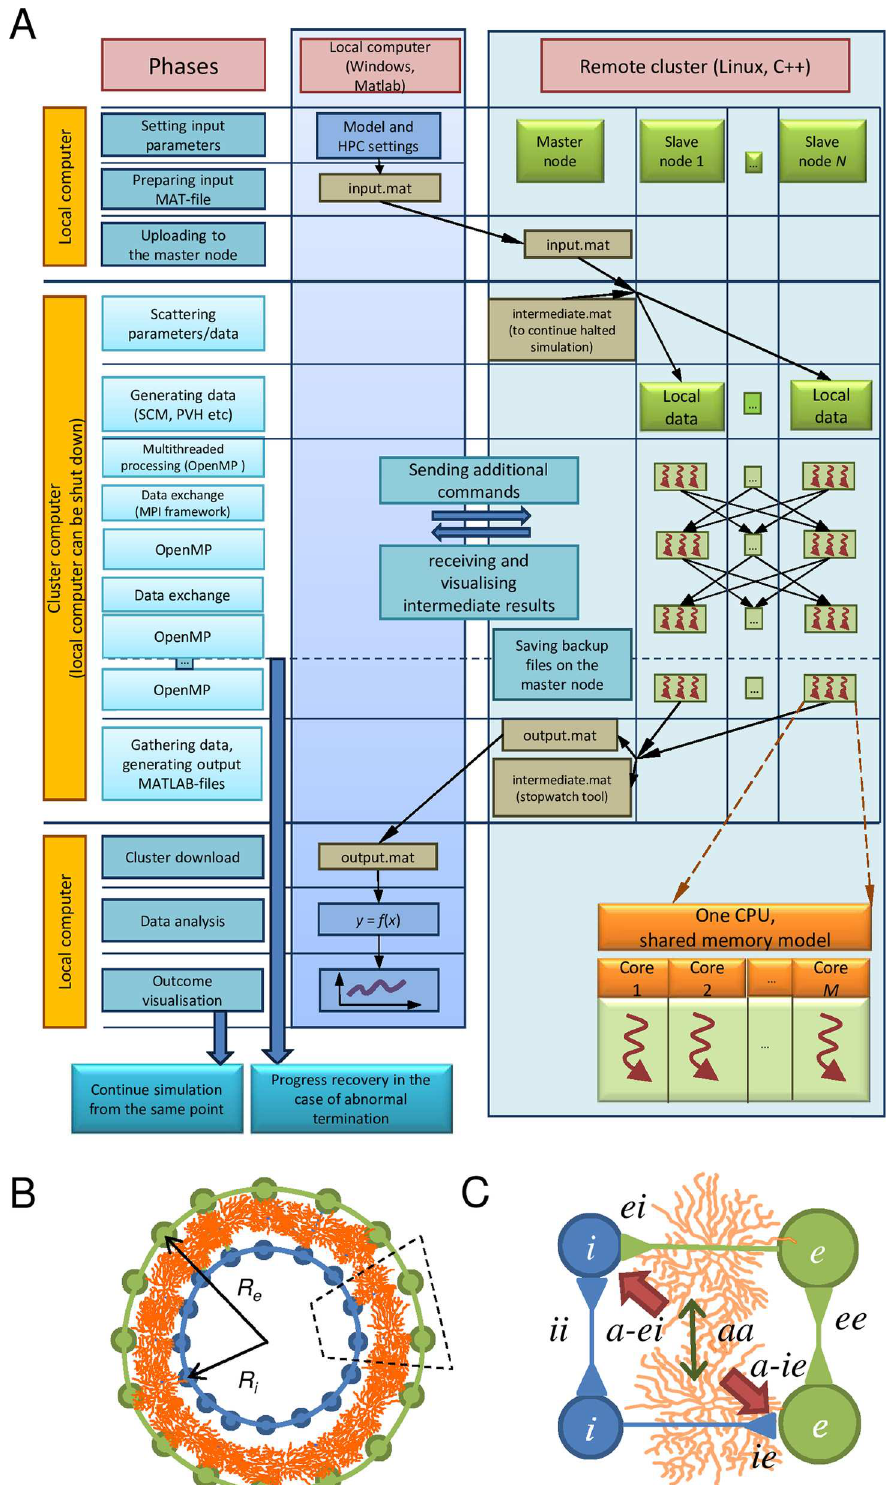
Fig 1. Structure of ARACHNE and simulated network types. (A) General diagramof the ARACHNE simulator. In brief, local computer generatesthe model and the HPC configuration as input.mat file, which is sent to the remote computer with master and slaves N clusters. Each slave computer has M processors.